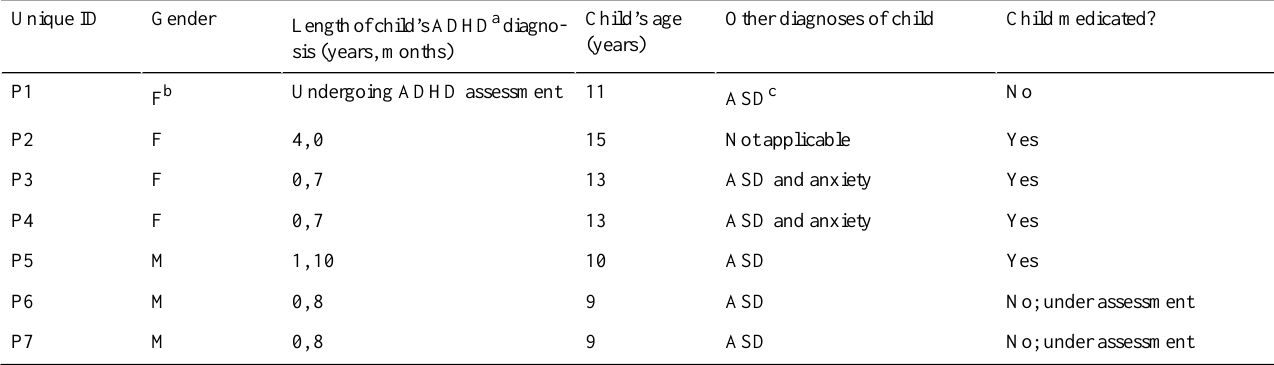
Table 2. Demographic characteristics of